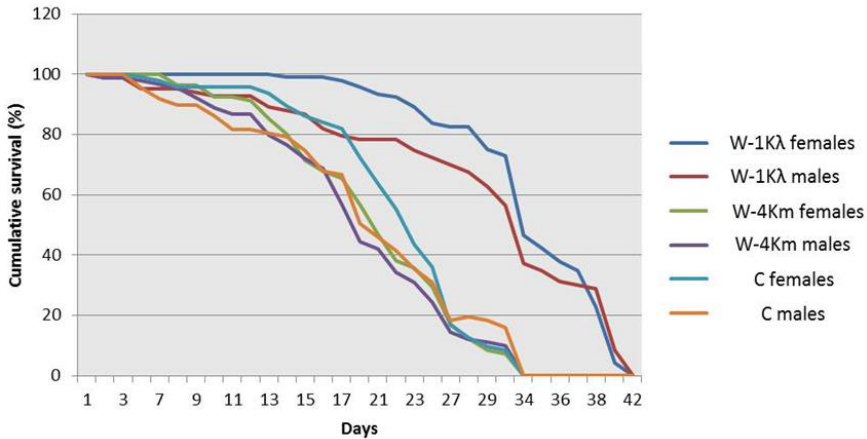
Figure 2. Adult longevity of males and females from the lambda-cyhalothrin-resistant W-1Kλ strain, the susceptible C strain, and the malathion-resistant W-4Km strain of Ceratitis capitata . Kaplan–Meier survival curves were compared using the Log-Rank test (Mantel–Cox) at p ≤ 0.05. Different letters mean significant differences.